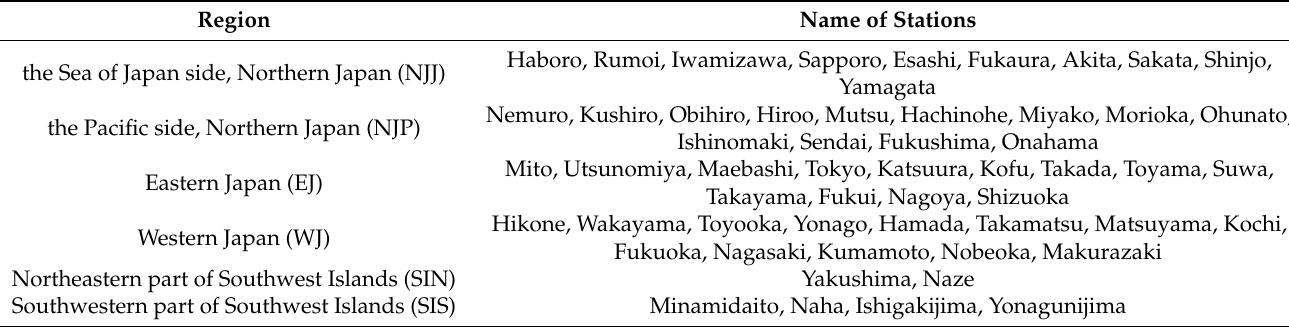
Table 1. Meteorological stations for the six regions of Japan defined in this